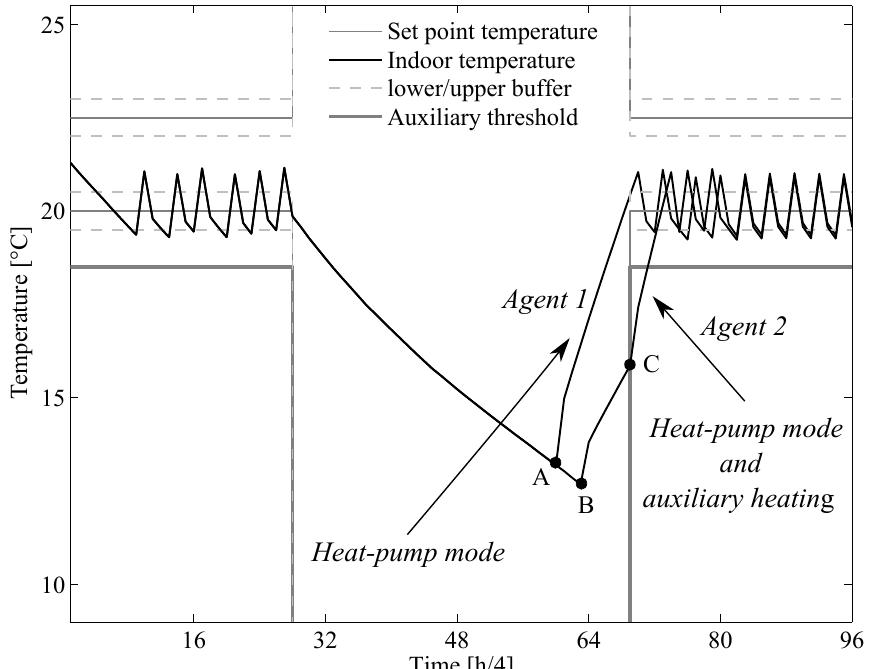
Figure 1. Indoor temperature of two thermostat agents with a set-back strategy (7–17 h). Agent 1 operates in normal heat-pump mode, and Agent 2 activates the less e ffi cient auxiliary